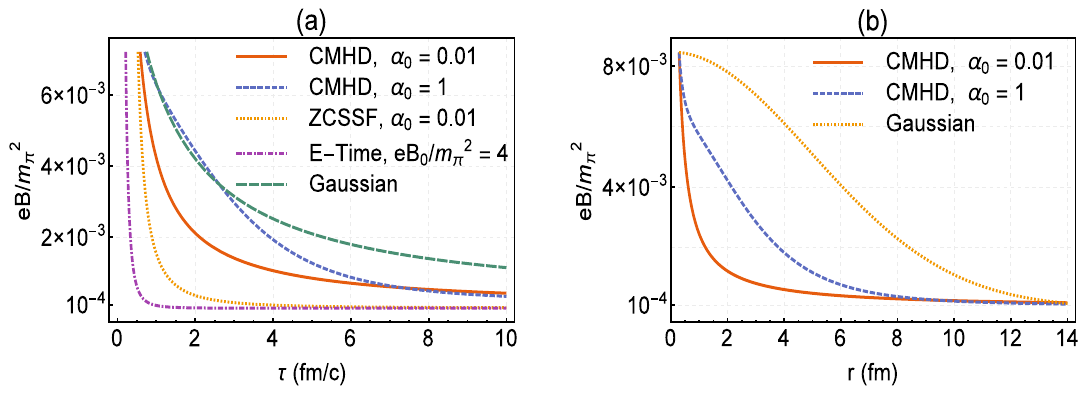
Figure 10 . (color online). (a) The τ dependence of eB/m 2 π is plotted for the CMHD solution with α 0 = 0 . 01 , 1 as well as 1 /q = 4 . 3 fm, the ZCSSF solution for α 0 = 0 . 01, the early time dynamics (7.6) (denoted by “E-Time”) for eB 0 = 4 mπ 2 , and the phenomenological Gaussian ansatz for r = r 0 (denoted by “Gaussian”) (7.7). The τ dependence of (7.7) is roughly τ − 1 , while (7.6) ones is approximately τ − 3 . The CMHD solution transmits between τ − 1 at early times to τ − 3 at late times. The CMHD solution with larger α 0 turns out to be more similar to the Gaussian ansatz. The ZCSSF solution is more similar to the early time dynamics, and changing α 0 does not significantly modify this behavior (not shown). (b) The r dependence of eB/m 2 π is plotted for the CMHD solution with α 0 = 0 . 01 , 1 and 1 /q = 4 . 3 fm as well as for the Gaussian ansatz for τ = τ 0 . Although for larger α 0 , the magnetic field survives up to larger distances to the origin, but the r dependence of the CMHD solution remains quite different from the r dependence of the Gaussian ansatz